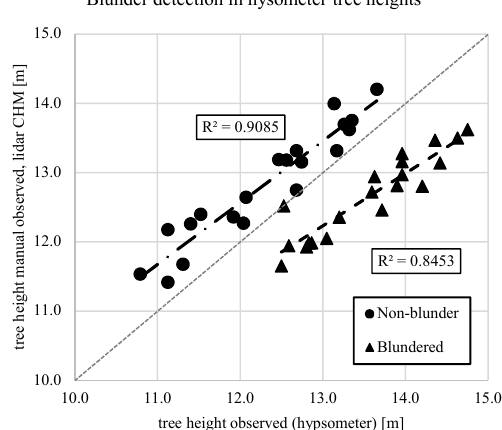
Figure 6. For the WG2 subplot, a blunder was detected in the field measurements provided by the timber cruise. This error is likely due to a poorly-calibrated hypsometer.